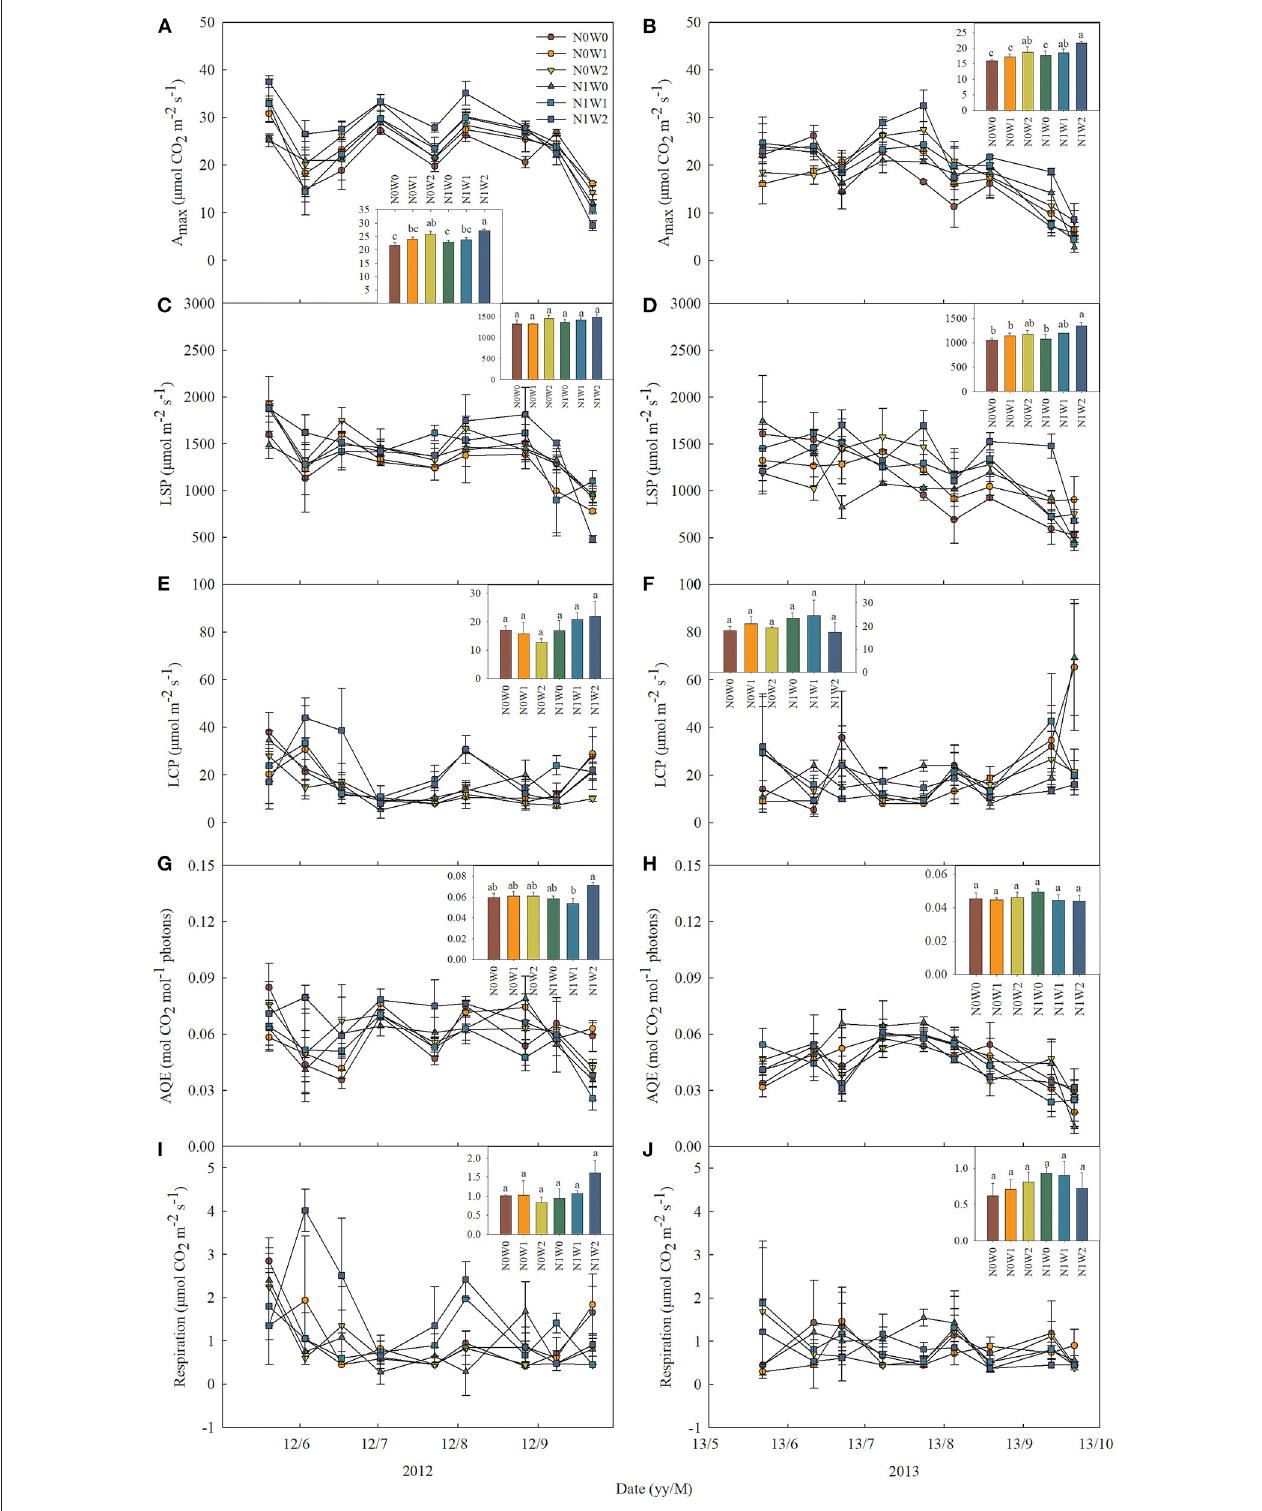
FIGURE 2 | Seasonal dynamics of leaf photosynthetic characteristics of Leymus chinensis in 2012 (left panels) and 2013 (right panels), respectively, including (A,B) the maximum photosynthetic rate (A max ), (C,D) light saturation point (LSP), (E,F) light compensation point (LCP), (G,H) maximum apparent quantum yield (AQE), and (I,J) respiration. Inset figures show the average values across seasons with different letters indicating significant differences ( P < 0.05) among the six treatments. Values represent mean ± SE ( n = 3).